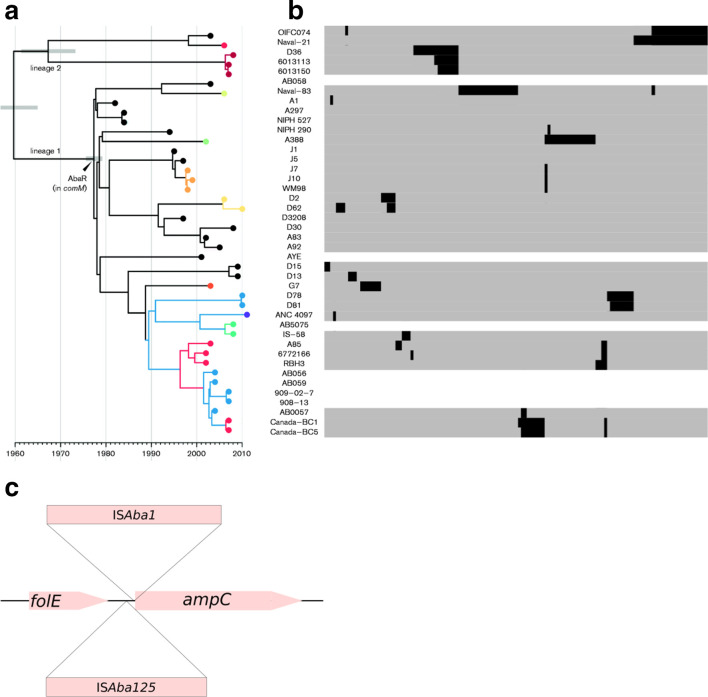
Phylogenic analysis of
A. baumannii
 GC1. (a) Temporal and phylogenetic analysis performed by Holt et al. [13]. The dot colours represent the capsule type of each isolate. (b) Hierarchical clustering based on the presence/absence of 345 IS-related events implicating 19 ISs in 35 isolates of
A. baumannii
 with available SRA data. Each of the 345 columns represents one IS-related event, with grey indicating no event, black indicating an event and white if the sequence data could not be obtained. (c) Representation of the insertion of ISAba1 and ISAba125 upstream from ampC.